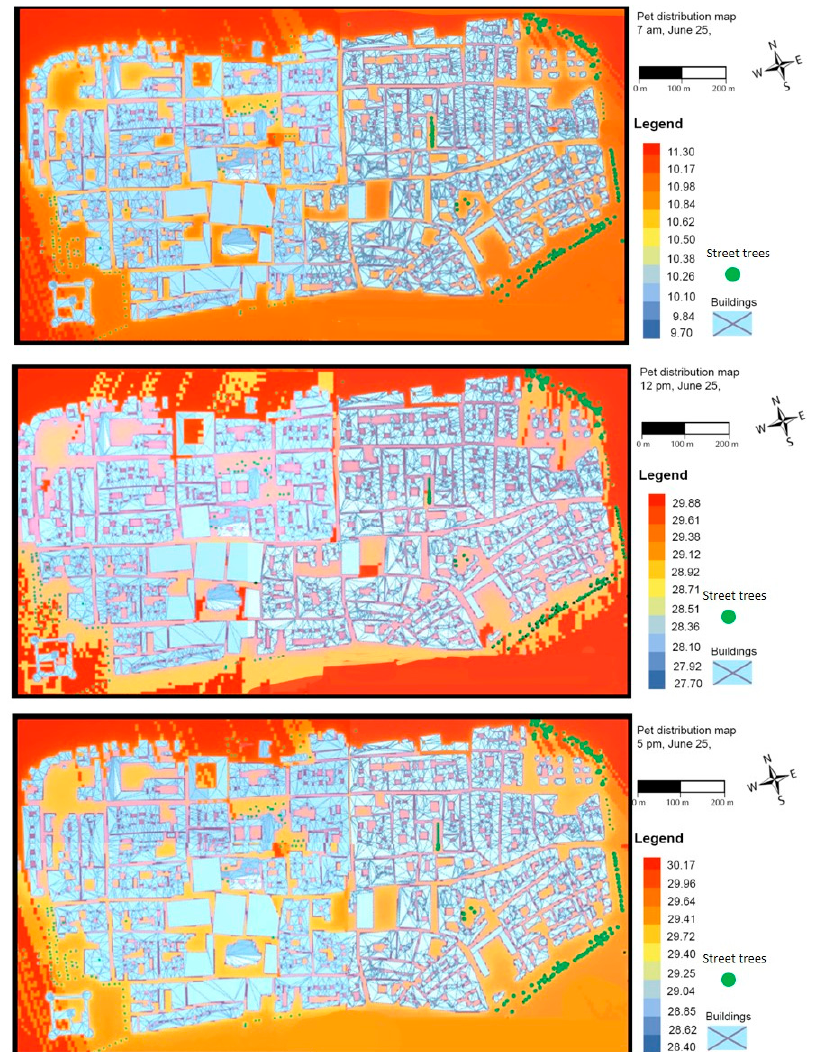
Figure 5. Spatial Variation of Physiological Equivalence temperature in Imola, on the 25th of June.